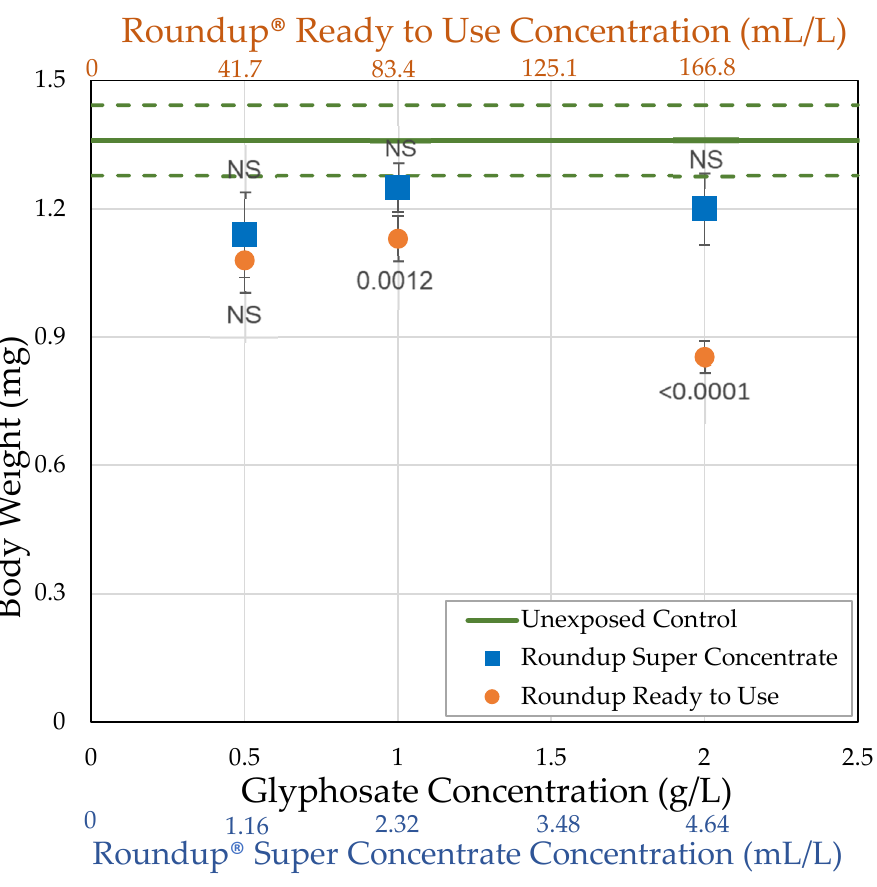
Figure 2. Average body weight of D. melanogaster females unexposed (control) or exposed to herbicide in their food medium within 2 h of eclosion for 7 days (± std. error). The p -values shown are based on the t -tests in Table 2.